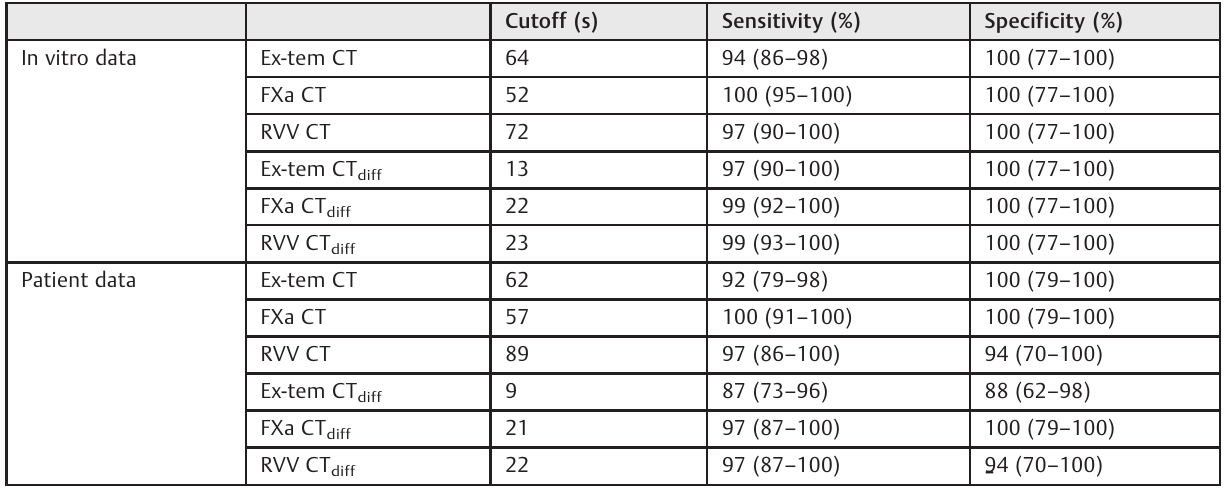
Table 1 Optimal receiver operating characteristics (ROCs) for discriminating between samples with apixaban concentration above or below 20 ng/mL in both the in vitro material and patient material